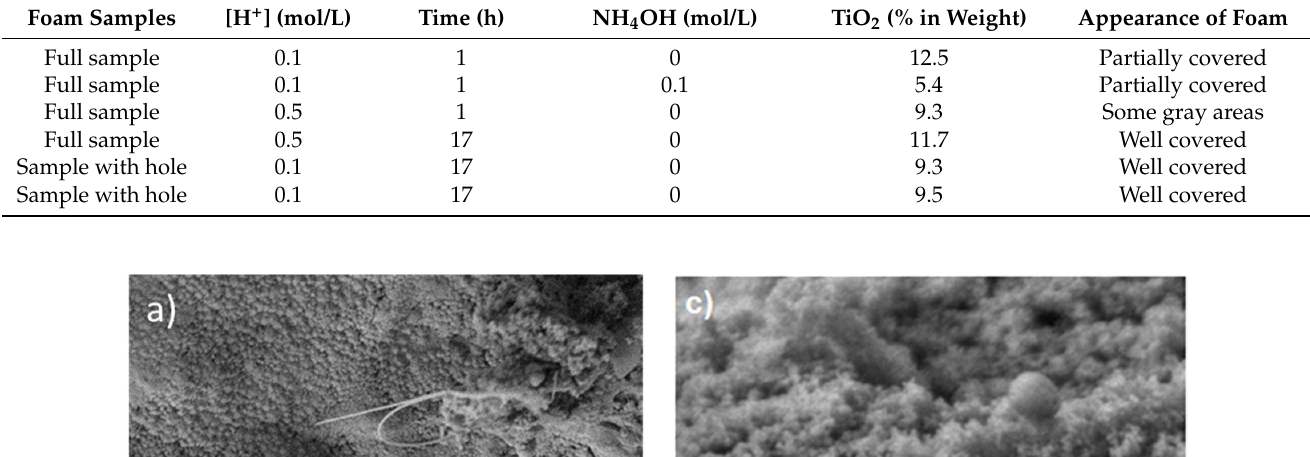
Table 1. Results of the different impregnations with TiO 2 -P25 following the different chemical treatments of β -SiC foams.